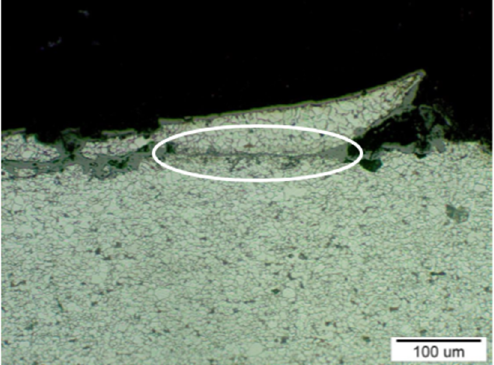
Figure 12. The area with the beginning of the crack extension in the steel structure, according to Figure 10, where it is marked with a white outline; etch, Nital.